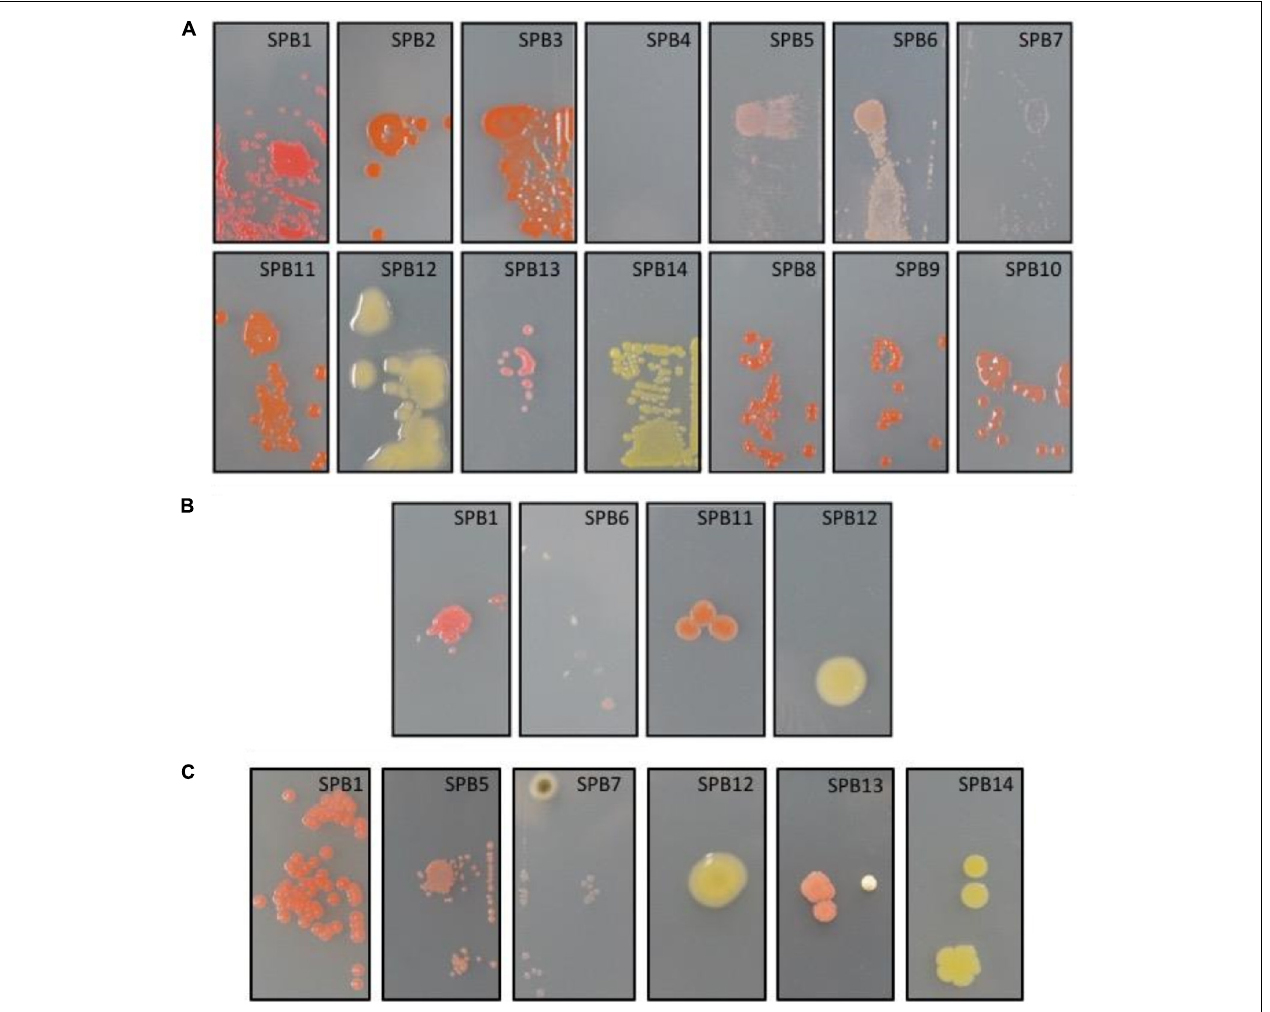
FIGURE 2 | (A) Glass-adhesion test performed as described in M&M. From left to right, top: isolates SPB1, SPB2, SPB3, SPB4, SPB5, SPB6, SPB7; bottom: SPB11, SPB12, SPB13, SPB14, SPB8, SPB9, and SPB10. (B) UV-resistance test performed on glass-adhering cells as described in M&M. From left to right isolates SPB1, SPB6, SPB11, and SPB12. The three later correspond to the growth of only 1-3 UV-resistant colonies each. (C) Desiccation-resistance test performed on glass-adhering cells as described in M&M. From left to right isolates SPB1, SPB5, SPB7, SPB12, SPB13, and SPB14. Isolates correspond to: SPB1, Arthrobacter ; SPB2, Hymenobacter ; SPB3, Hymenobacter ; SPB4, Rhodococcus (uranium-contaminated site); SPB5, Methylobacterium ; SPB6, Deinococcus ; SPB7, Arthrobacter agilis ; SPB8, Hymenobacter ; SPB9, Hymenobacter ; SPB10, Hymenobacter perfusus-uranium ; SPB11, Hymenobacter perfusus-uranium ; SPB12, Curtobacterium ; SPB13, Curtobacterium ; and SPB14, Arthrobacter agilis . The images are representative of the microscope slides (size 22X40